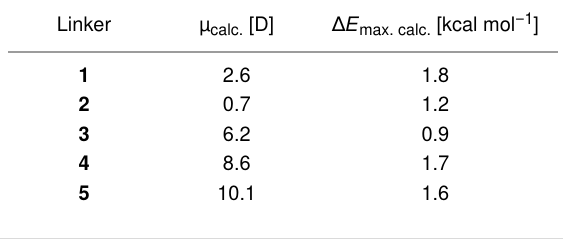
Table 1: DFT calculated dipole moments and rotational barriers of the dipolar rotors 1 – 5 . Geometry optimizations (symmetry 1 – 4 : C 2 v ; 5 : C 2 ) were performed with B3LYP/aug-cc-pVTZ level of theory and subse- quent Mullikan dipole moment analysis (analogue to Müllen et al. [32]). For an appraisal of rotational barriers rotational scans were performed at the PBE/def2SVP level of density functional theory. For this evalua- tion both carboxylic groups where fixed in a plane. In all cases, barriers for rotations are below 2 kcal mol − 1 . In the absence of intermolecular interactions there should be thermally excited rotation at room temper- ature and down to very low temperatures.